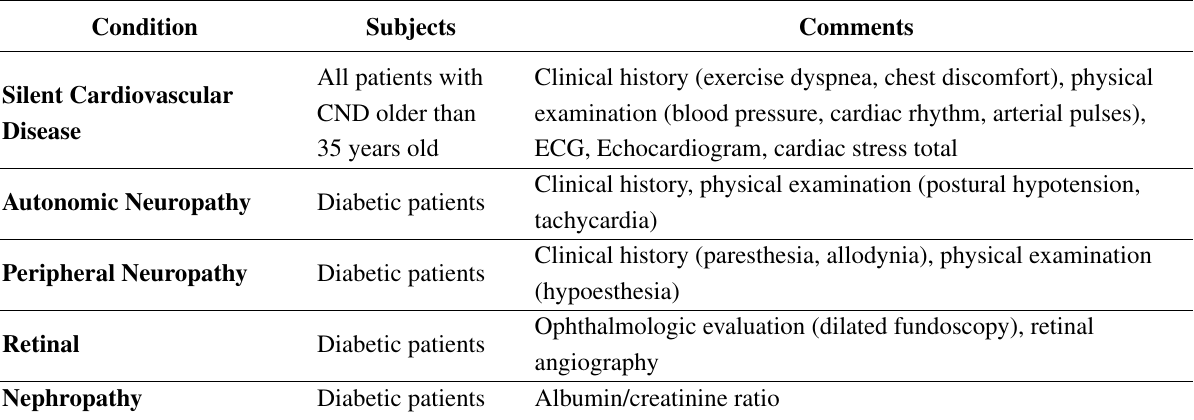
Table 4. Screening Before Beginning a Structured Physical Activity